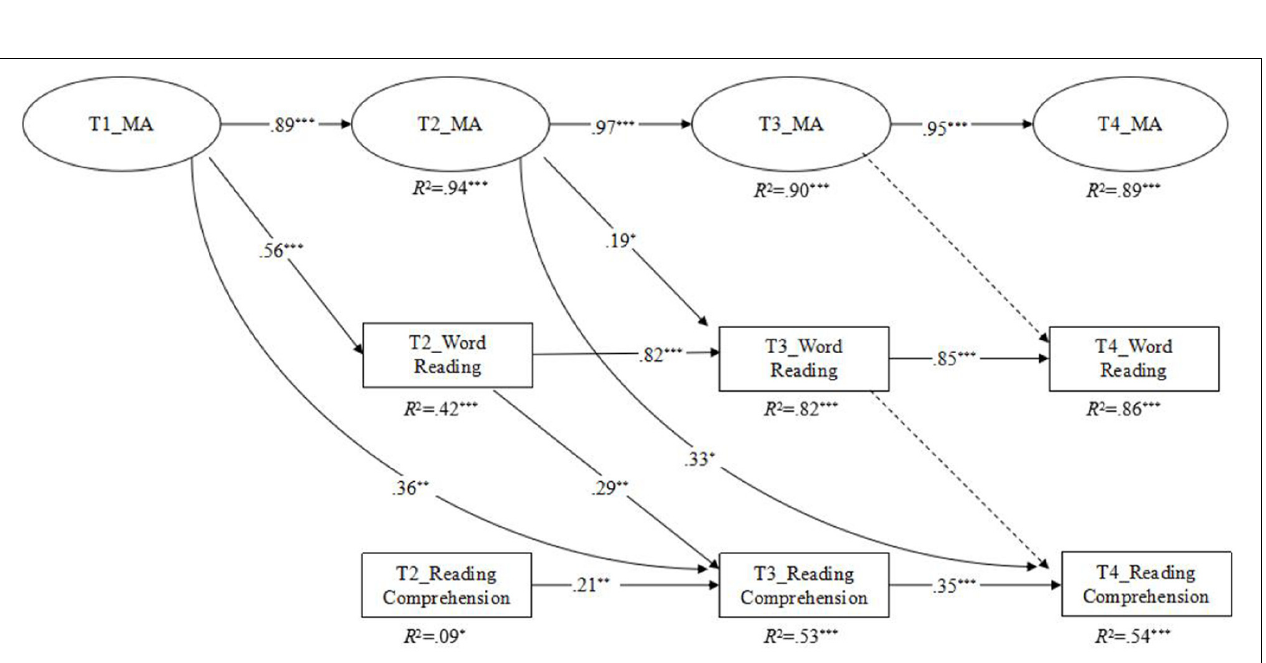
FIGURE 2 | The final model ( M 4 ) with a completely standardized solution to address the relationship between MA and RC after controlling for phonological awareness, vocabulary knowledge, and general cognitive ability. MA, morphological awareness; CA, compounding awareness; HPA, homophone awareness; HNA, homonym awareness. Dashed lines indicate non-significant paths. ∗ p < 0.05, ∗∗ p < 0.01, ∗∗∗ p < 0.001, two-tailed.